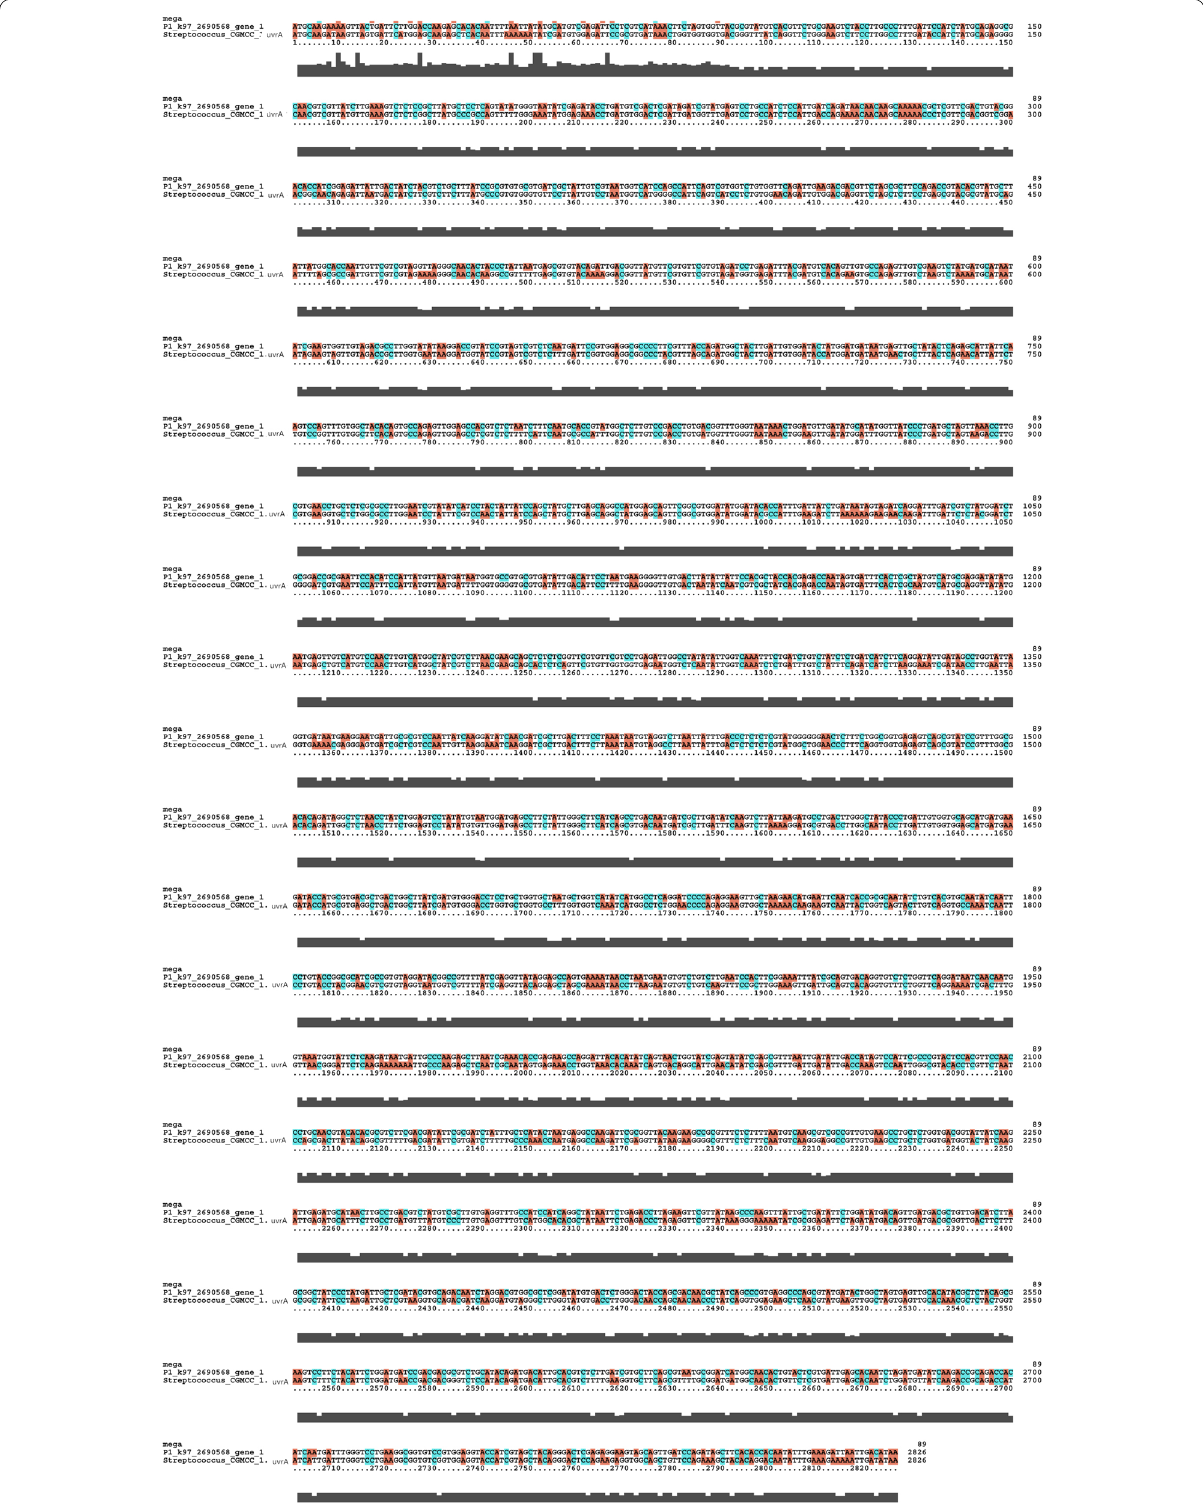
Fig. 4 Structural differences between uvrA and mo-uvrA